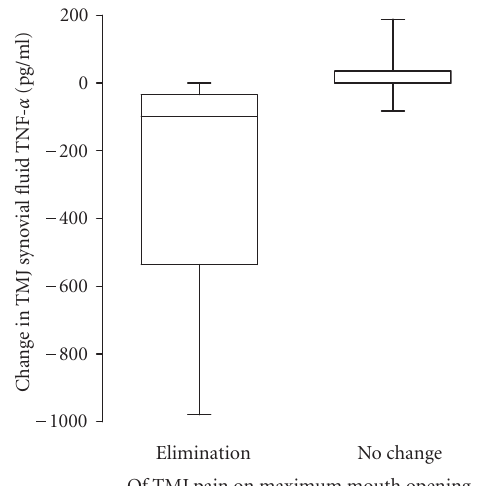
Figure 1: Individual changes in temporomandibular joint (TMJ) synovial fluid levels of tumor necrosis factor- α (TNF- α ) before and after (median interval: 40 days) intra-articular glucocorticoid treat- ment in 21 female patients with chronic inflammatory TMJ disor- der. Eight patients had undetectable synovial fluid levels of TNF- α at both occasions. The patients with detectable pretreatment syn- ovial fluid level of TNF- α showed a reduction of the mediator from a median of 65 to a median of 0.